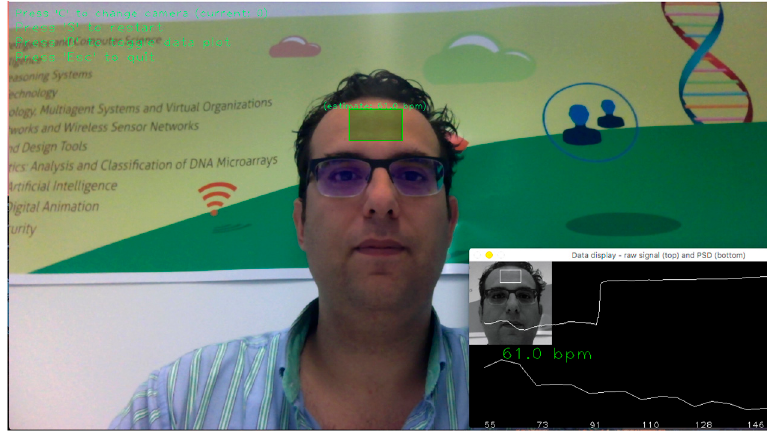
Figure 6. Example of the pulse measuring system in use.